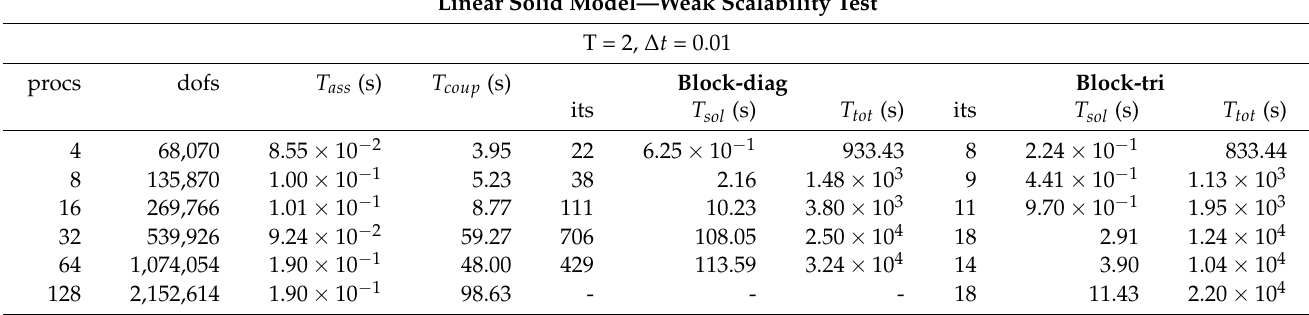
Table 2. Weak scalability for the linear solid model. The simulations are run on the Shaheen cluster. Same format as Table 1. Linear Solid Model—Weak Scalability Test T = 2, ∆ t =